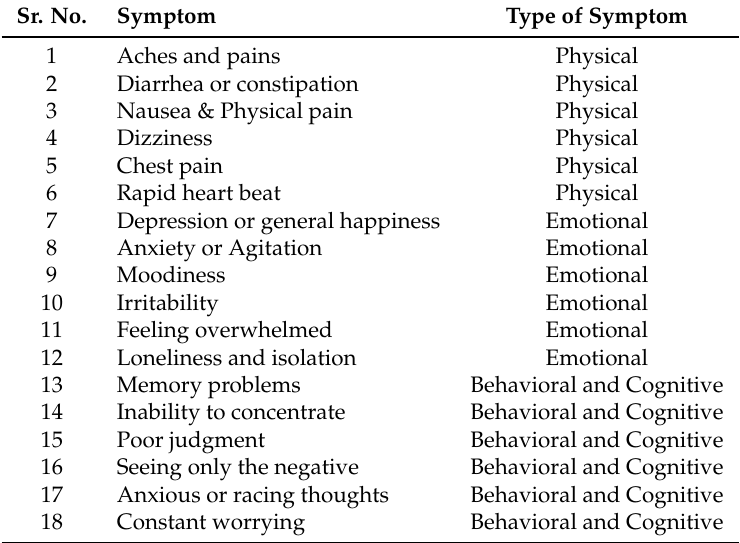
Table 1. The symptoms evaluated by expert psychologist during the interview process. Sr. No. Symptom Type of Symptom 1 Aches and pains Physical 2 Diarrhea or